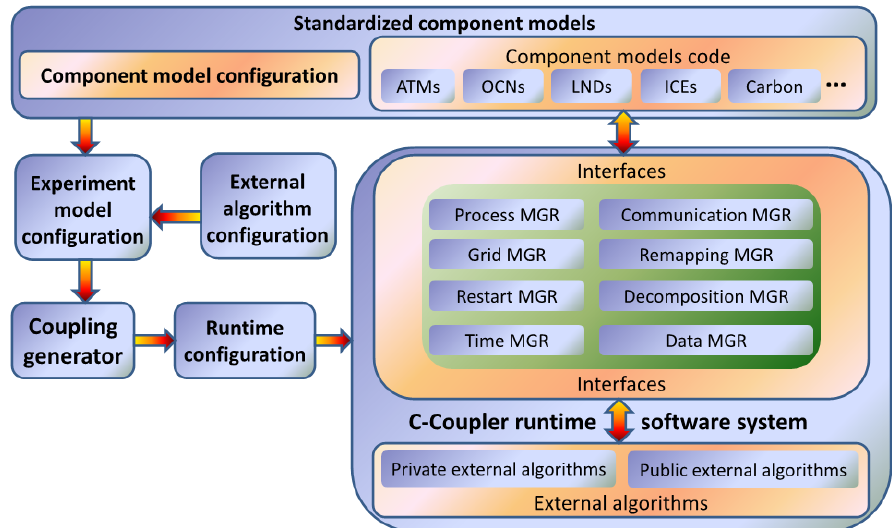
Fig. 2. The general software architecture of the C-Coupler. 2 Figure 2. The general software architecture of